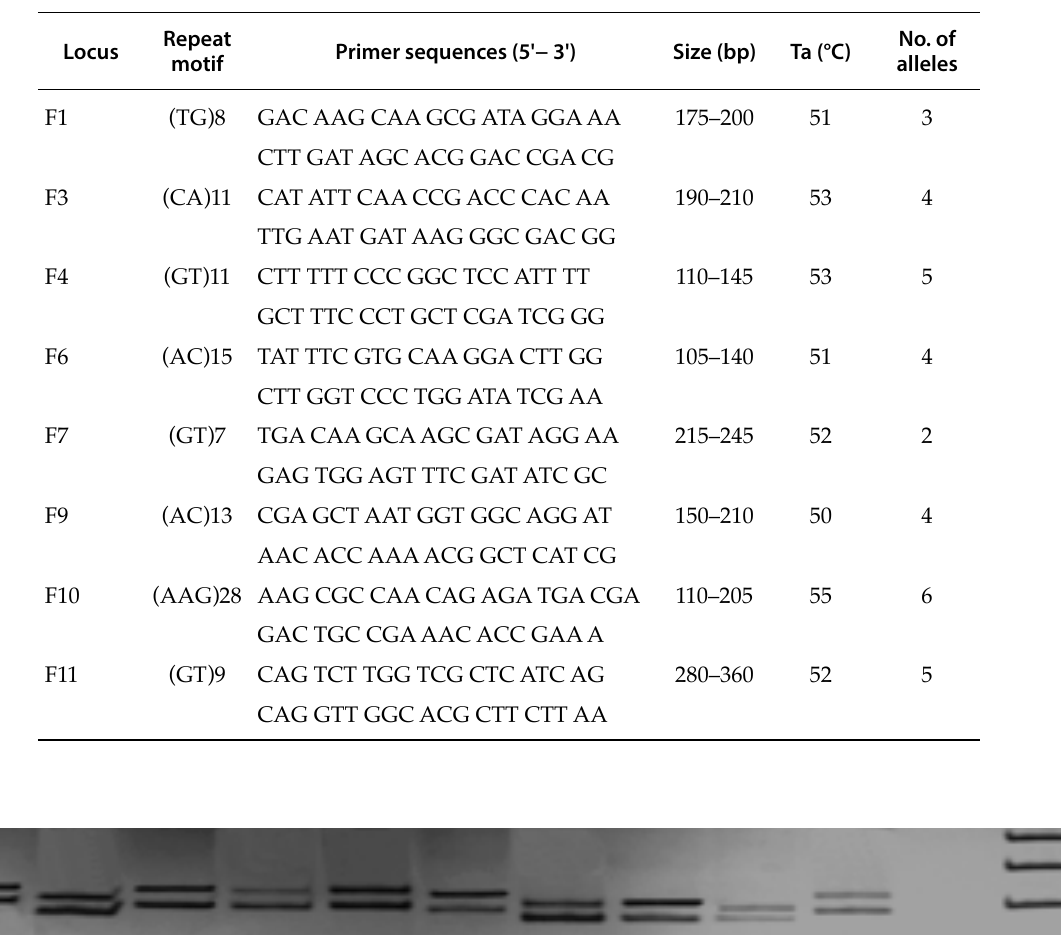
Table 1. Repeat motif, primer sequences, range of fragment size, optimum annealing temperature and number of alleles detected by eight pairs of SSR markers in isolates of Fusarium culmorum.